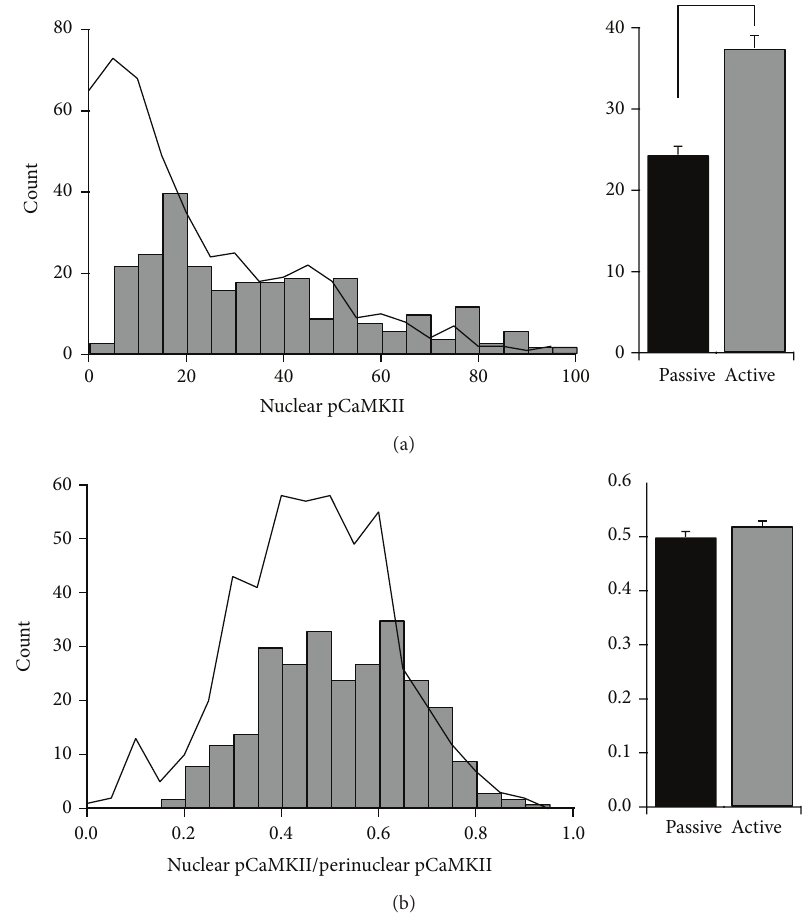
Figure 6: Experience-dependent regulation of nuclear pCaMKII. (a) Left , frequency histograms of nuclear pCaMKII signal in passive (black line) versus active adults (gray bars). Right , mean values significantly increased ( ∗∗∗ 𝑃 < 0.0001 , Mann-Whitney 𝑈 test). (b) Left , frequency histograms of nuclear pCaMKII/perinuclear pCaMKII in passive (black line) versus active adults (gray bars). Right , mean values were similar in magnitude and not significantly different ( 𝑃 = 0.02 , Mann-Whitney 𝑈